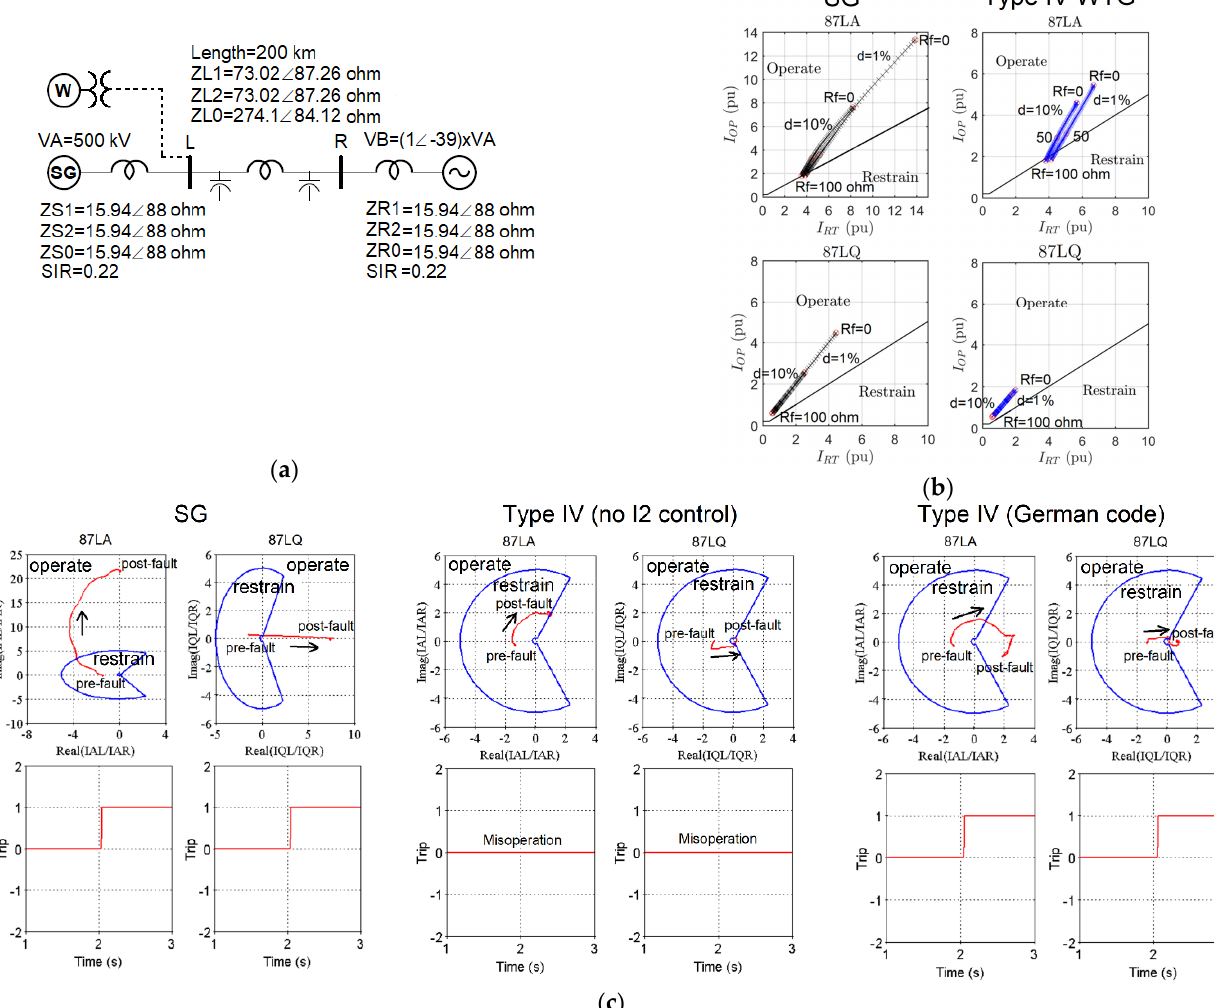
Figure 11. ( a ) The 500 kV two-source test system; ( b ) trajectories of a traditional LCD for a phase-A-to-G fault at different locations and various fault resistance values under SG and Type IV WTG with no I2 control; and ( c ) trajectories of an Alpha Plane LCD for a phase-A-to-ground fault under SG, Type IV WTG with no I2 control, and Type IV WTG with I2 control based on the German grid code.